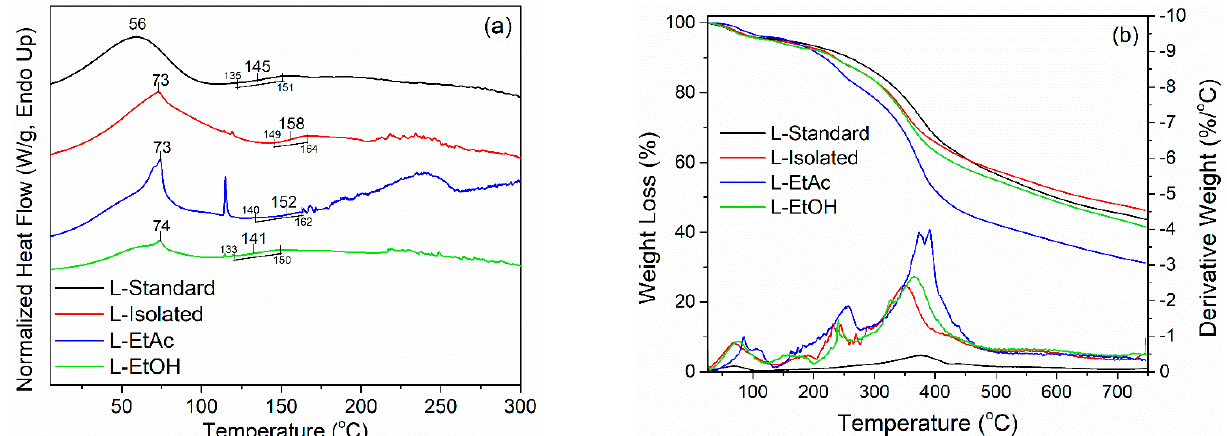
Figure 2. Thermal characteristics of lignin ( a ) DSC, ( b ) TGA-DTG.